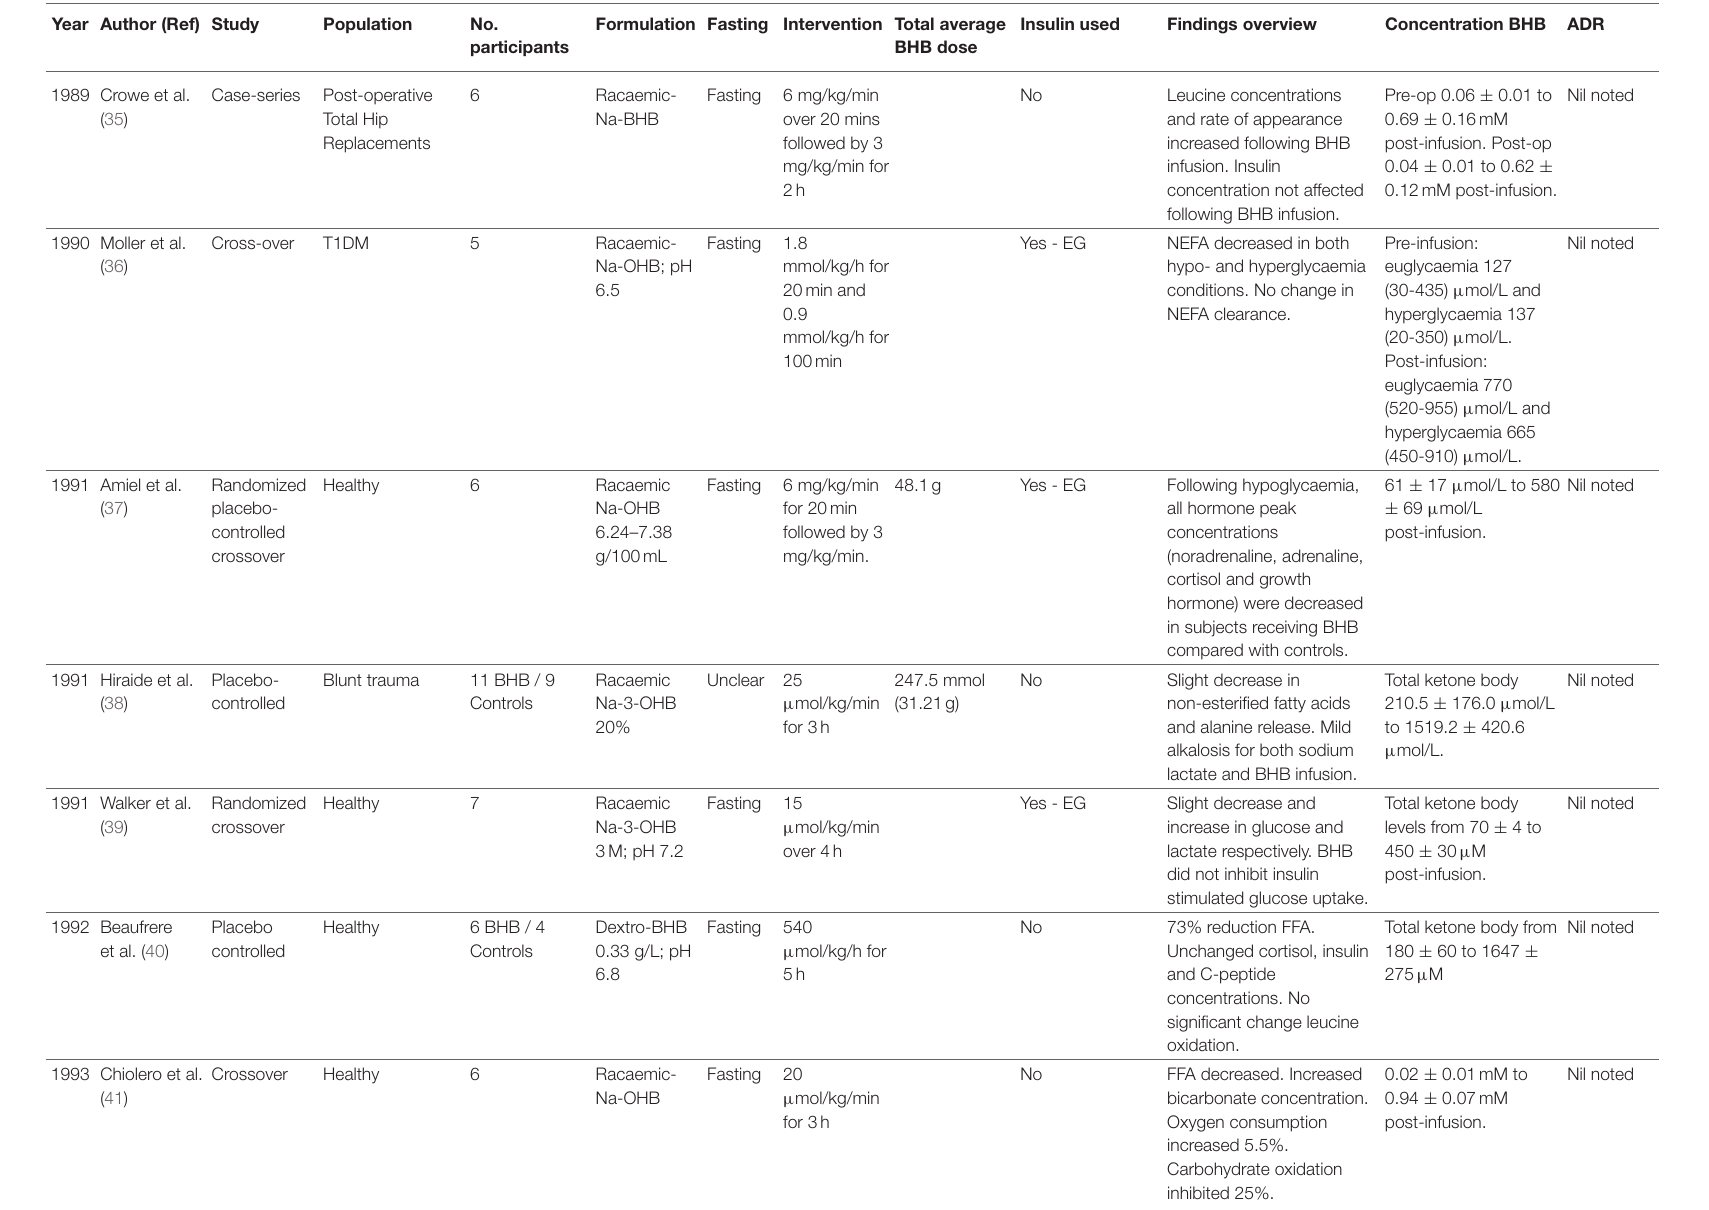
FFA decreased. Increased bicarbonate concentration. Oxygen consumption increased